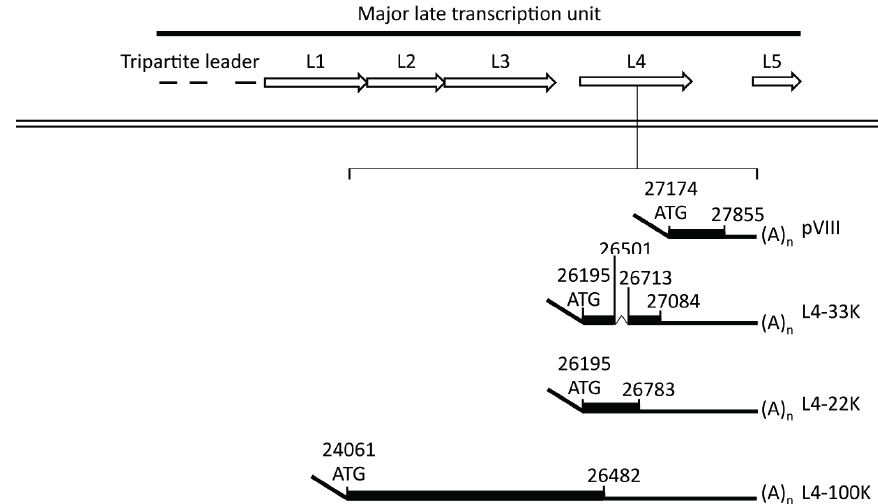
Figure 3. Schematic drawing highlighting the structure of the mRNAs expressed from the L4 unit. The adenoviral major late transcription unit (MLTU) contains five coding regions called L1-5, indicated by open arrows. The dsDNA adenoviral genome is represented as a double black line. The L4 transcripts (pVIII, L4-33K, L4-22K, L4-100K), with the corresponding genomic regions in Ad5 and their splicing pattern, are